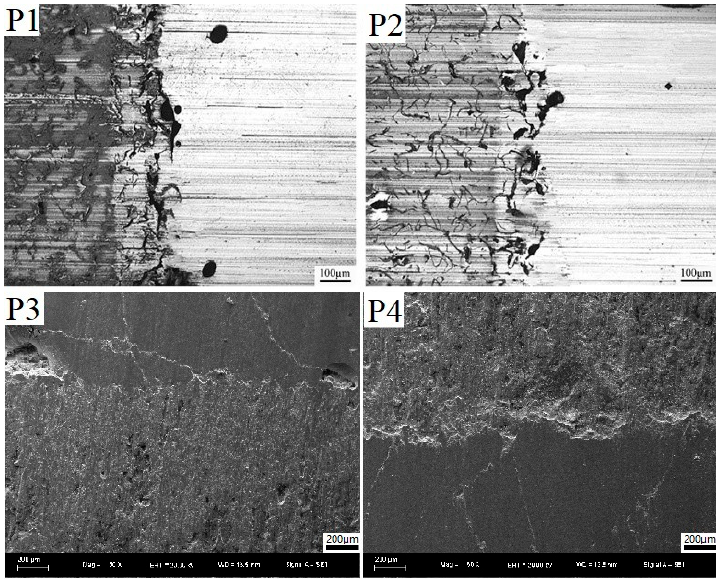
Figure 18. Surface wear morphology of different unit combinations after 600 thermal fatigue cycles.